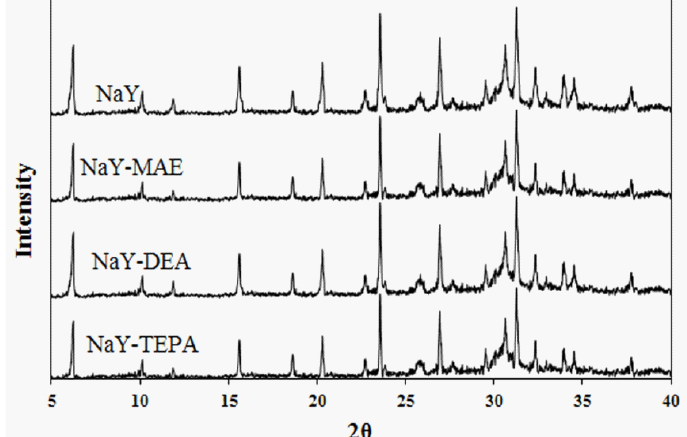
Fig. 2. XRD patterns of the NaY before and after different amines